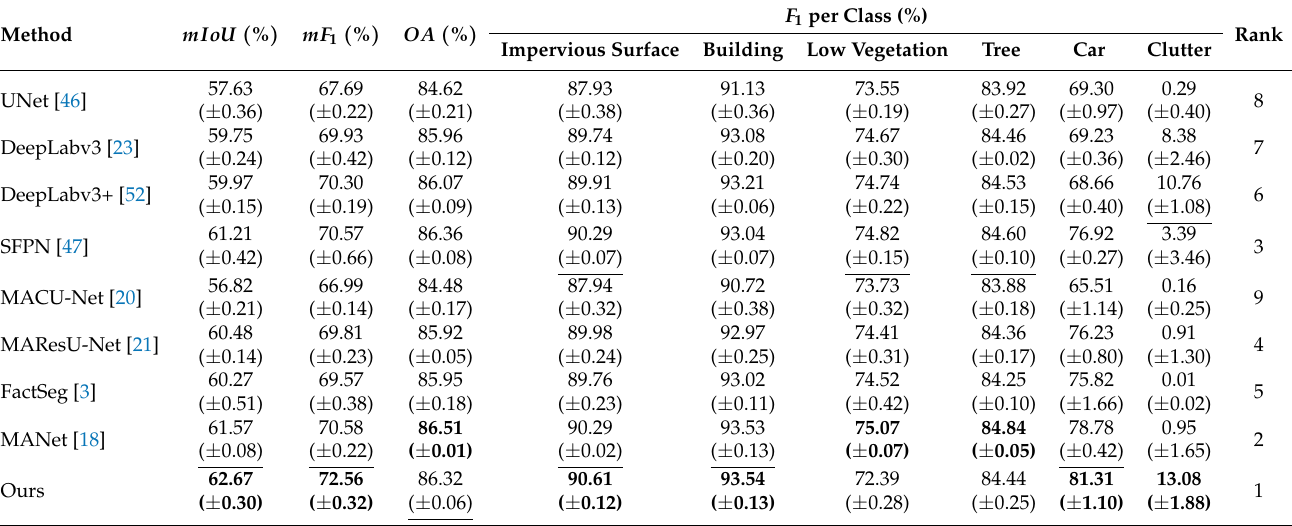
Table 3. The quantitative results of PGNet and SOTA methods on the ISPRS Vaihingen dataset.